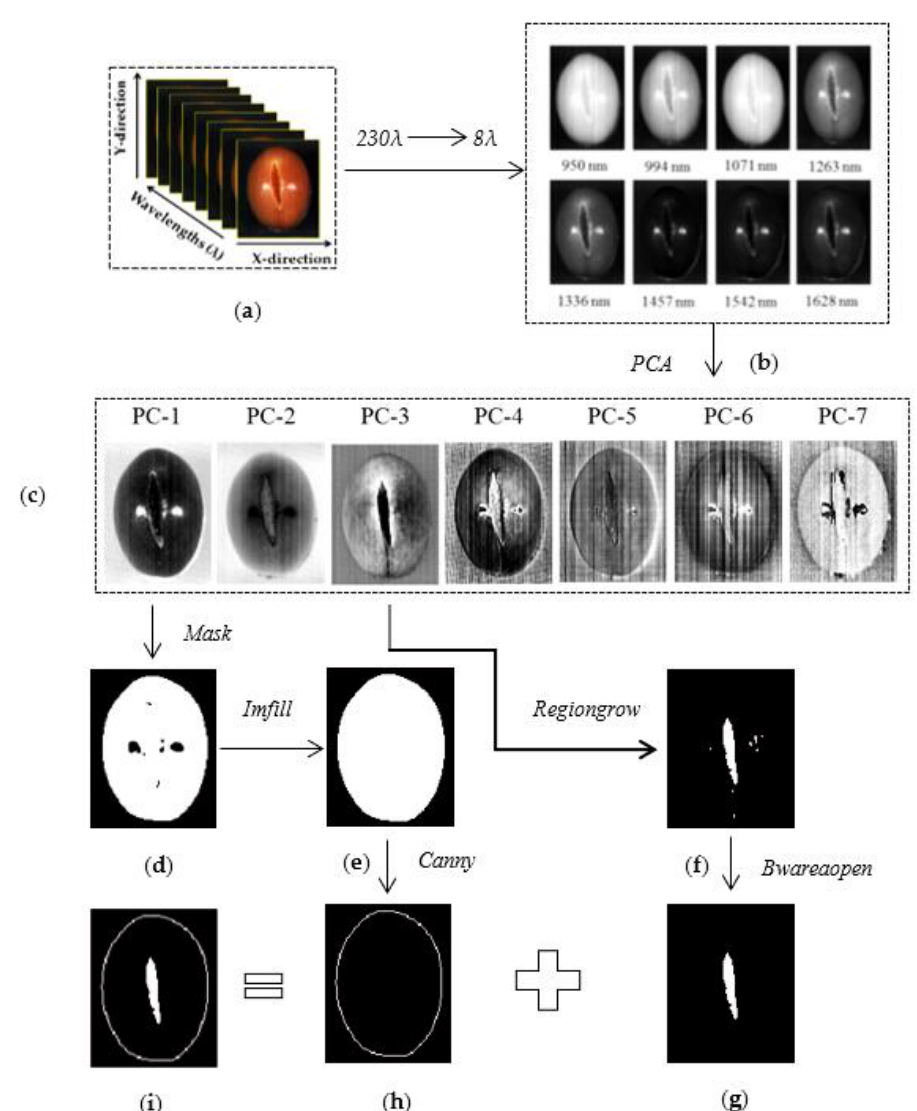
Figure 9. Flow chart of the involvement of the cracked feature algorithm in the Cerasus humilis fruit sample: ( a ) hyperspectral image; ( b ) grayscale image; ( c ) PCA; ( d ) mask; ( e ) imfill; ( f ) regiongrow; ( g ) bwareaopen; ( h ) canny; ( i ) imadd.